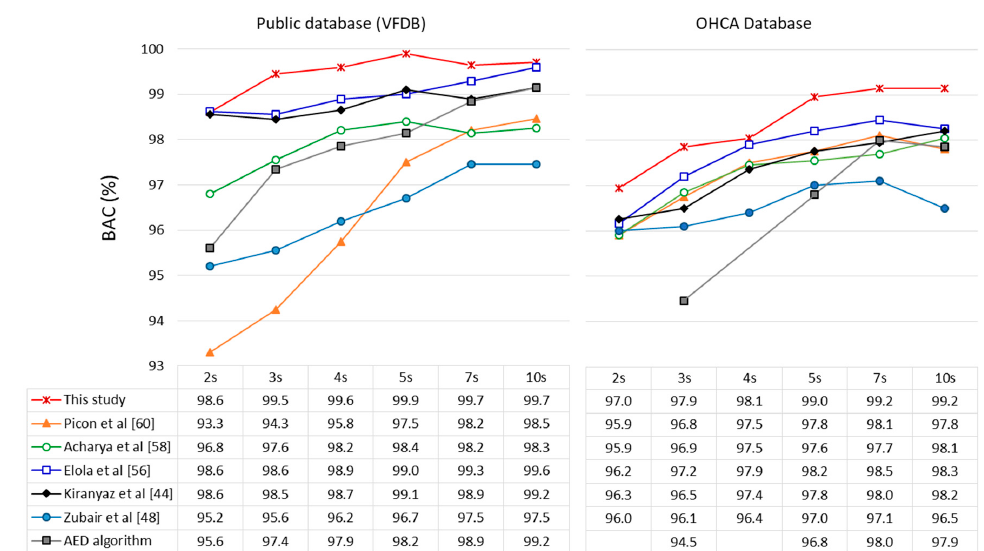
Figure 11. Comparative study of our best model to published fully convolutional DNNs, which are trained and evaluated under the same conditions on public Holter and OHCA databases. BAC performance is reported on our validation dataset using analysis durations between 2 s and 10 s. The performance of the reference automatic external defibrillator (AED) algorithm is reported for the same databases, taken from Krasteva et al. [19] for VFDB, Didon et al. [7] (3, 5, 7 s) and Krasteva et al. [25] (10 s) for the OHCA database.